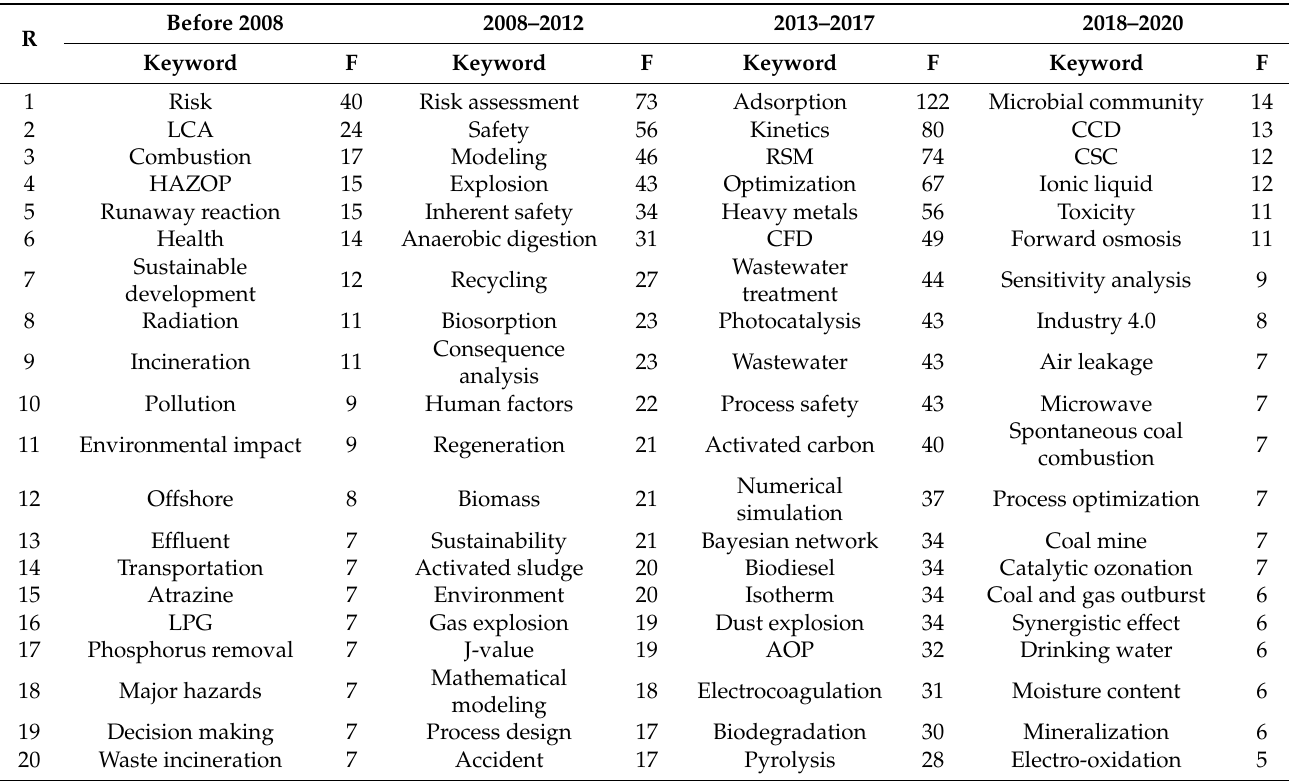
Table 7. Top 10 keywords for PSEP in terms of various periods.